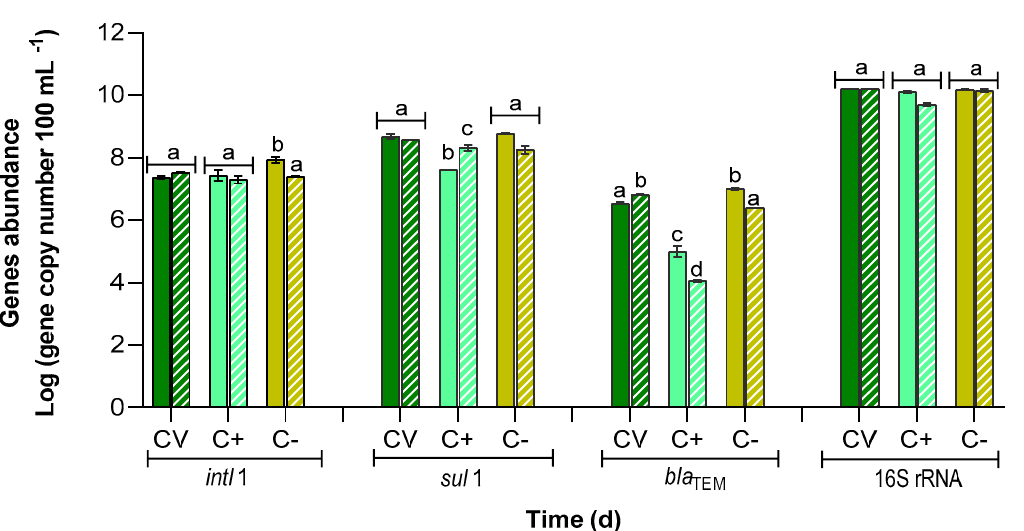
Figure 8. The abundance of the 16S rRNA, intl 1, and antibiotic resistance genes ( sul 1 and bla TEM ) detected in each PBR: (cid:4) CV ( C. vulgaris + UWW); (cid:4) C+ ( C. vulgaris + autoclaved UWW); and (cid:4) C − (raw UWW), at the beginning of the experiment (full colored bars) and after 9 d of treatment (striped bars). Results (average ± standard deviation) are expressed in a log (gene copy number 100 mL − 1 ). Bars of the same gene with the same letters are not statistically different (two-way ANOVA followed by Tukey post hoc test p < 0.05).